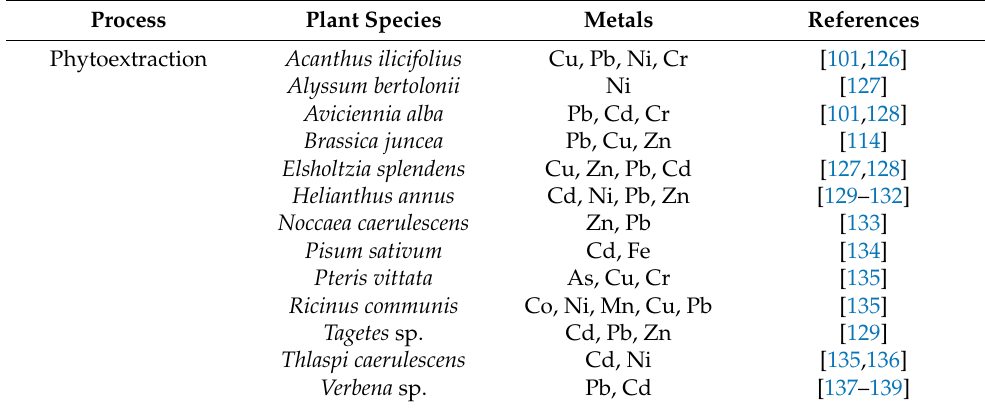
Table 3. Lists of plants which can be used in different phytoremediation